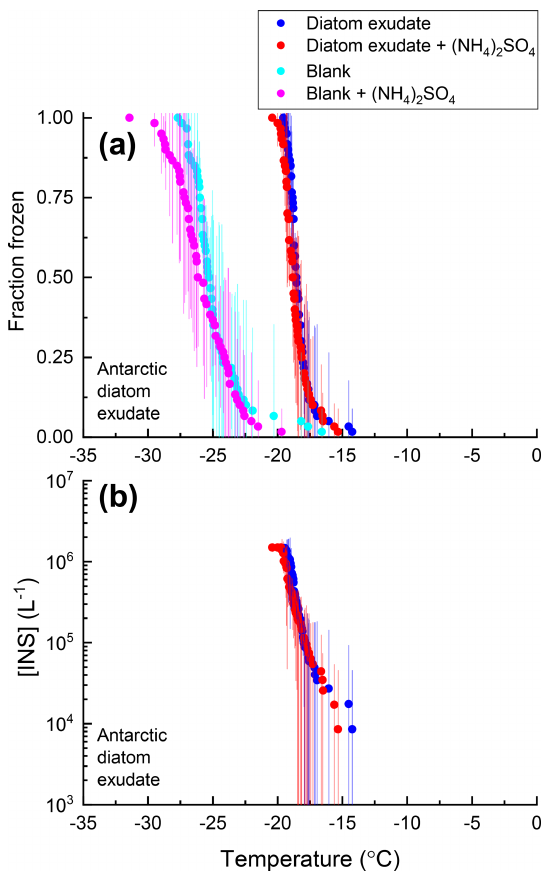
Figure 5. Fraction of droplets frozen (a) and the concentration of INS per liter of solution [INS( T )] (b) for samples of Antarctic di- atom exudates with (red) and without (blue) 0.05M(NH 4 ) 2 SO 4 compared with an ultrapure water blank with (pink) and with- out (cyan) 0.05M(NH 4 ) 2 SO 4 . Freezing data (both samples and blanks) have been corrected for freezing point depression by 0.05M(NH 4 ) 2 SO 4 . Error bars represent the 95% confidence in- terval of fraction frozen or [INS( T )] at temperature T calculated using Student’s t